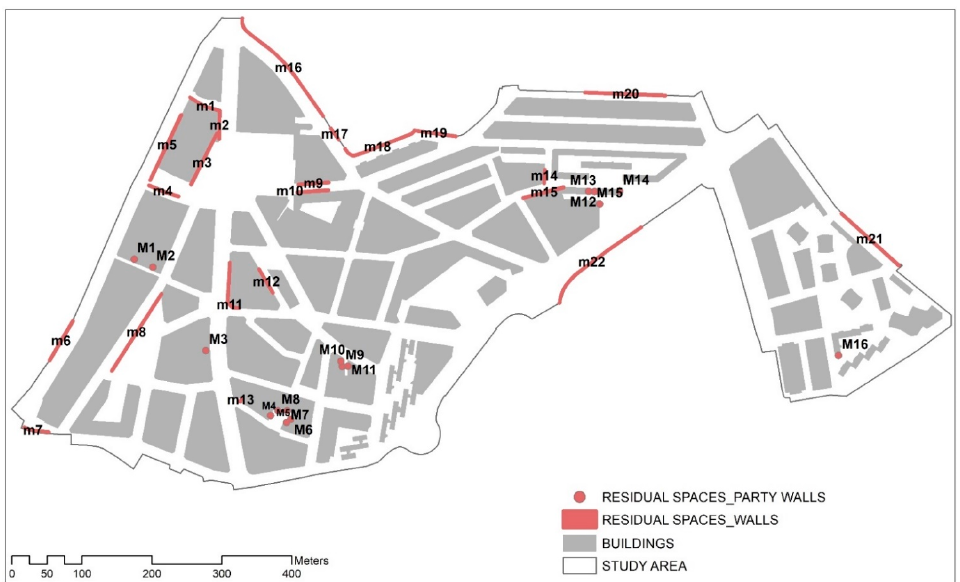
Figure 12. Map of residual surface spaces in La Milagrosa.